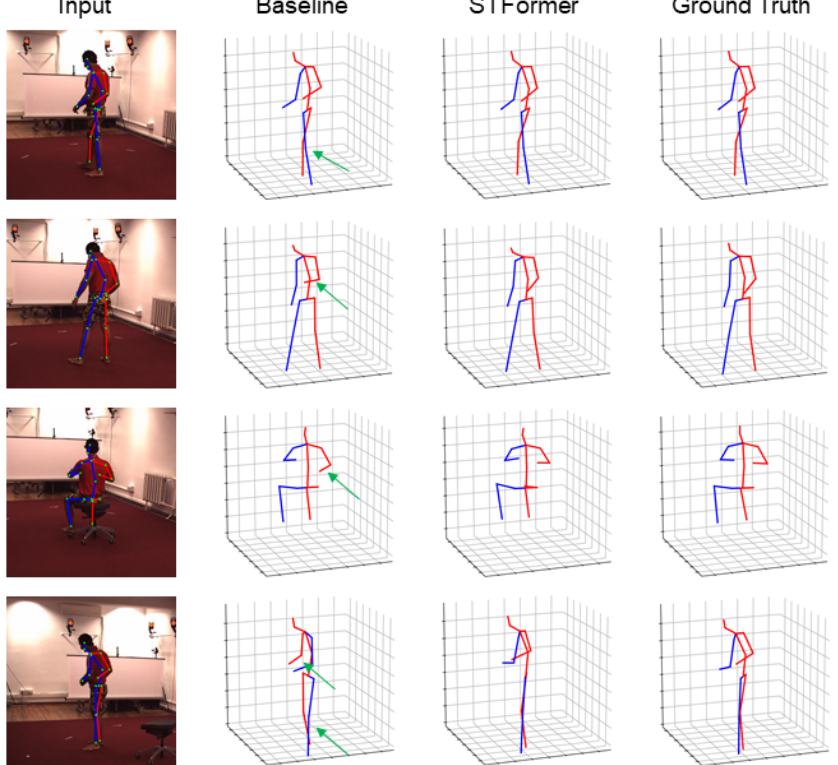
Figure 6. Qualitative comparison of the proposed method (STFormer) with the baseline method on the Human3.6M dataset. Incorrect estimates are highlighted with green